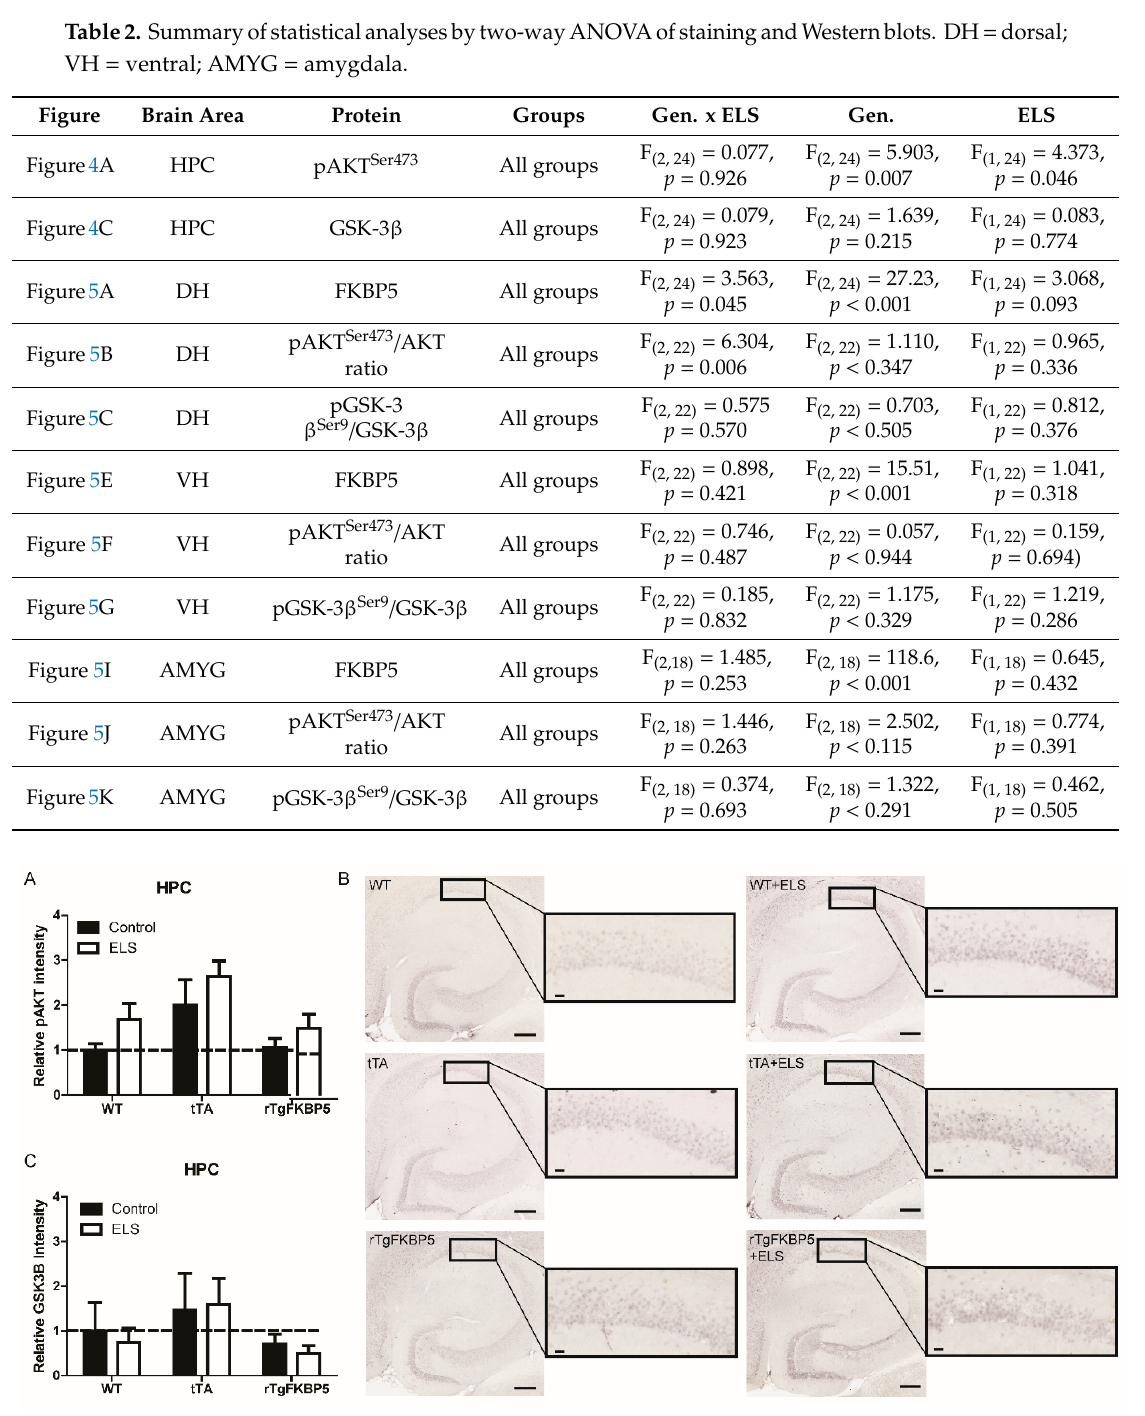
Figure 4. Early life stress increases phosphorylated AKT at Serine 473 (pAKT Ser473 ) in the hippocampus. ( A ) Relative intensity of pAKT Ser473 in the hippocampus (HPC) from WT = 6, tTA = 5, rTgFKBP5 = 5 mice and WT = 5, tTA = 5, rTgFKBP5 = 5 mice with ELS. ( B ) Representative images are shown. ( C ) GSK-3 β levels in the HPC from the same mice. Interaction of stress and genotype was analyzed by two-way ANOVA followed by Bonferroni correction when significant (see Table 2). Values are represented as standard error of the mean (SEM) and relative protein expression is normalized to WT-control mice (represented by dotted lines). ELS = early life stress. Scale bar represents 200 µm; inset scale represents 20 µm. AKT = Protein kinase B. Table 2. Summary of statistical analyses by two-way ANOVA of staining and Western blots. DH = dorsal; VH = ventral; AMYG = amygdala. Brain Area